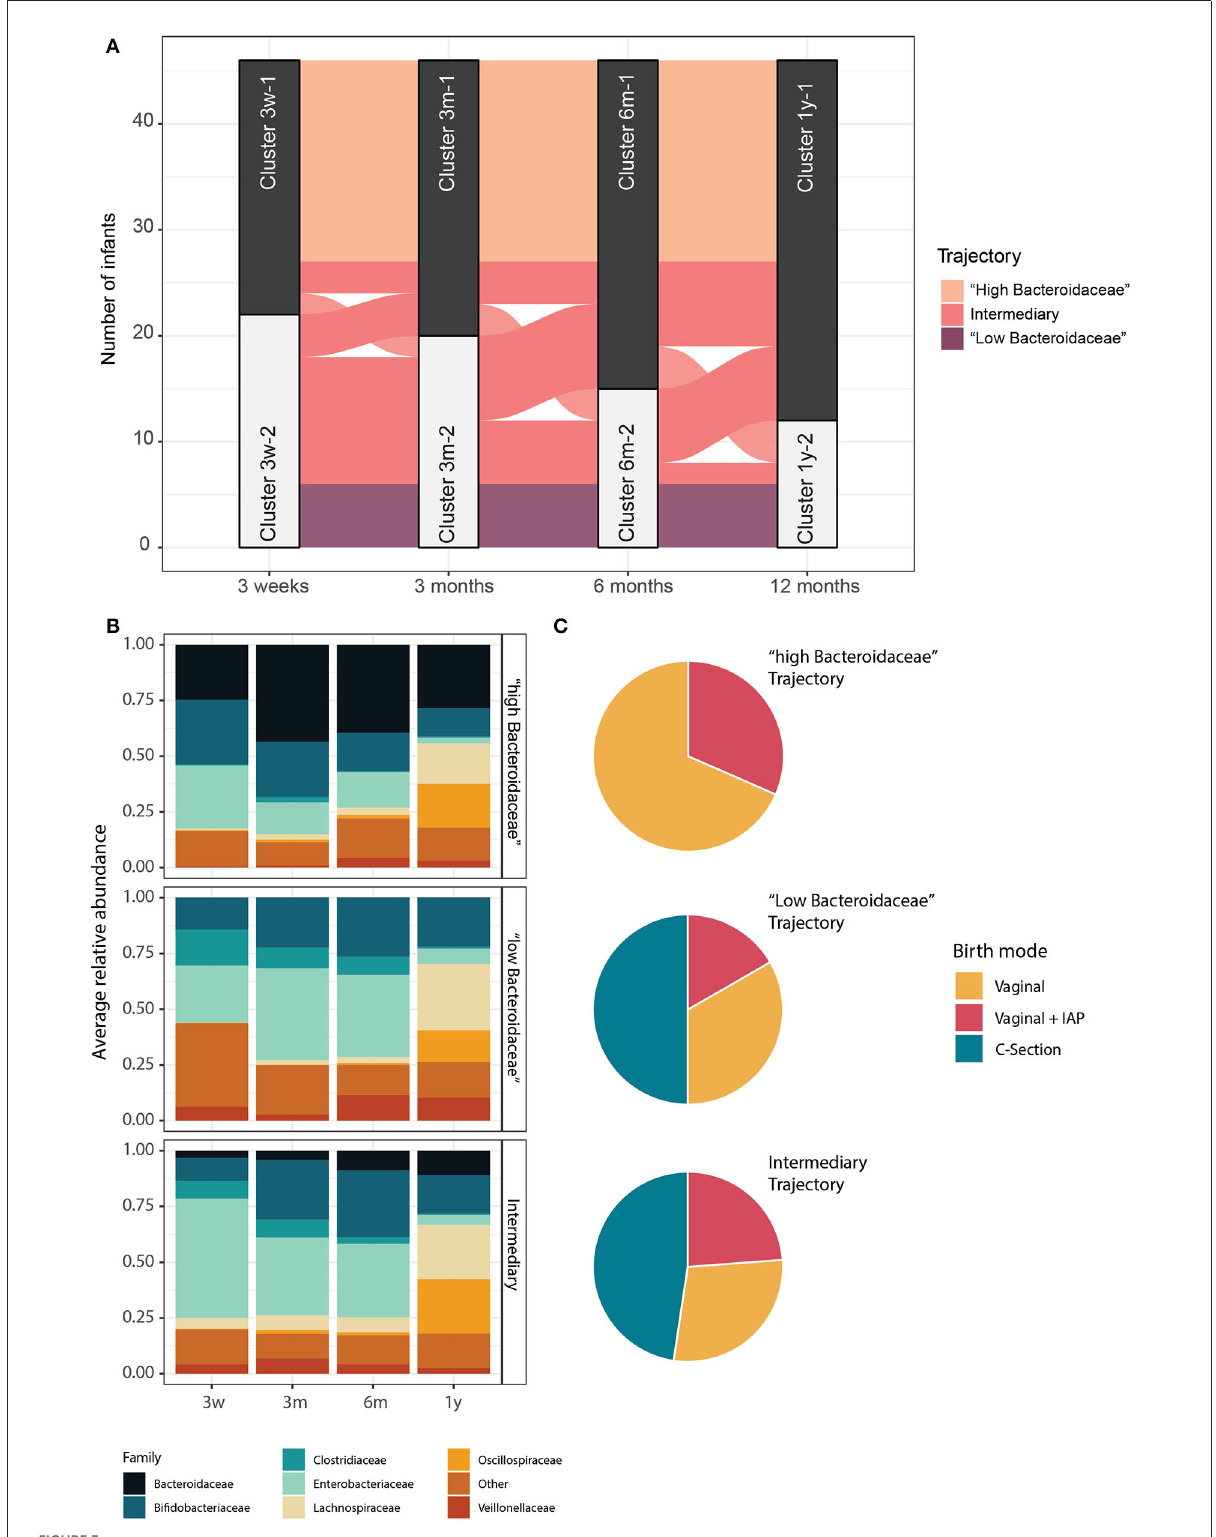
FIGURE3 Three major microbiota development trajectories identified. (A) Alluvial plot showing the evolution of infants’ microbiota trajectories through the first year of life, grouped according to the microbiota clusters identified at each time point. Groups of infants are colored according to the type of their trajectories. (B) Average relative abundance of bacterial families for infants within the same trajectory. Families with below 10% of relative abundance and prevalence are summed and grouped as “Other.” (C) The proportion of infants born by CS and VD infants with or without IAP in each